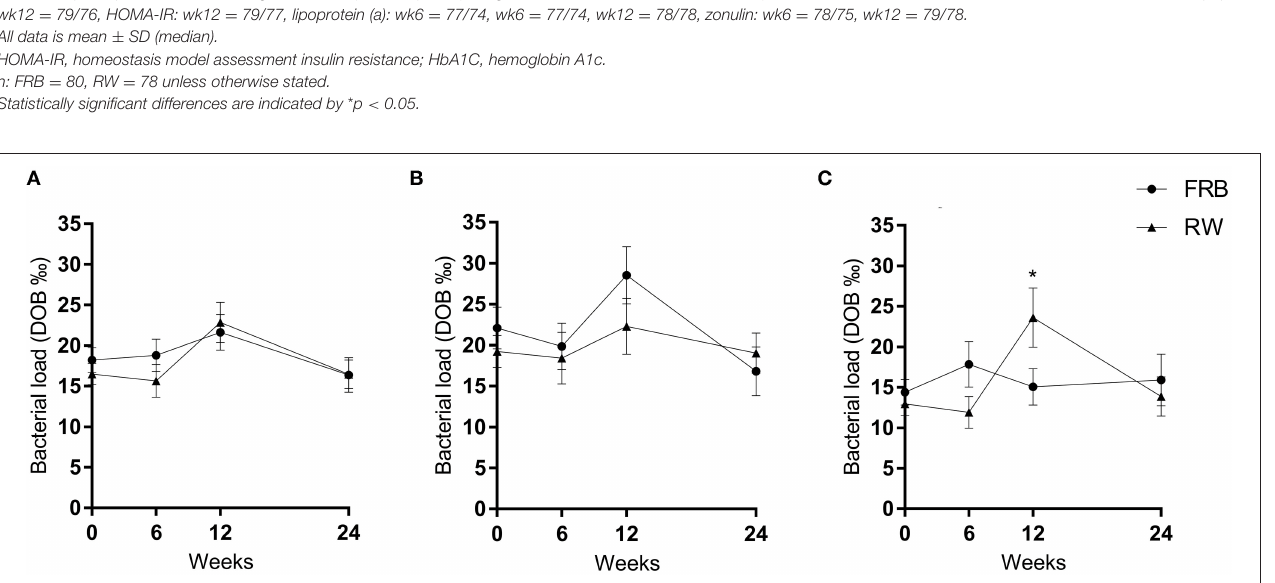
FIGURE 2 | Bacterial load measured 13 C-urea breath test at base-line, after 6 and 12 weeks of intervention and 12 weeks post intervention (week 24) in the fermented rye bran (FRB) and in the refined wheat (RW) group among all participants (A) and across normal weight participants (B) and overweight participants (C) . Data is mean ± SEM. DOB, delta-over-baseline. Statistically significant differences are indicated by * p <